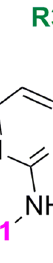
Figure 5. Common scaffold of cluster 3. R1, hydrogen; R2, alkyl; R3, substituted aromatic